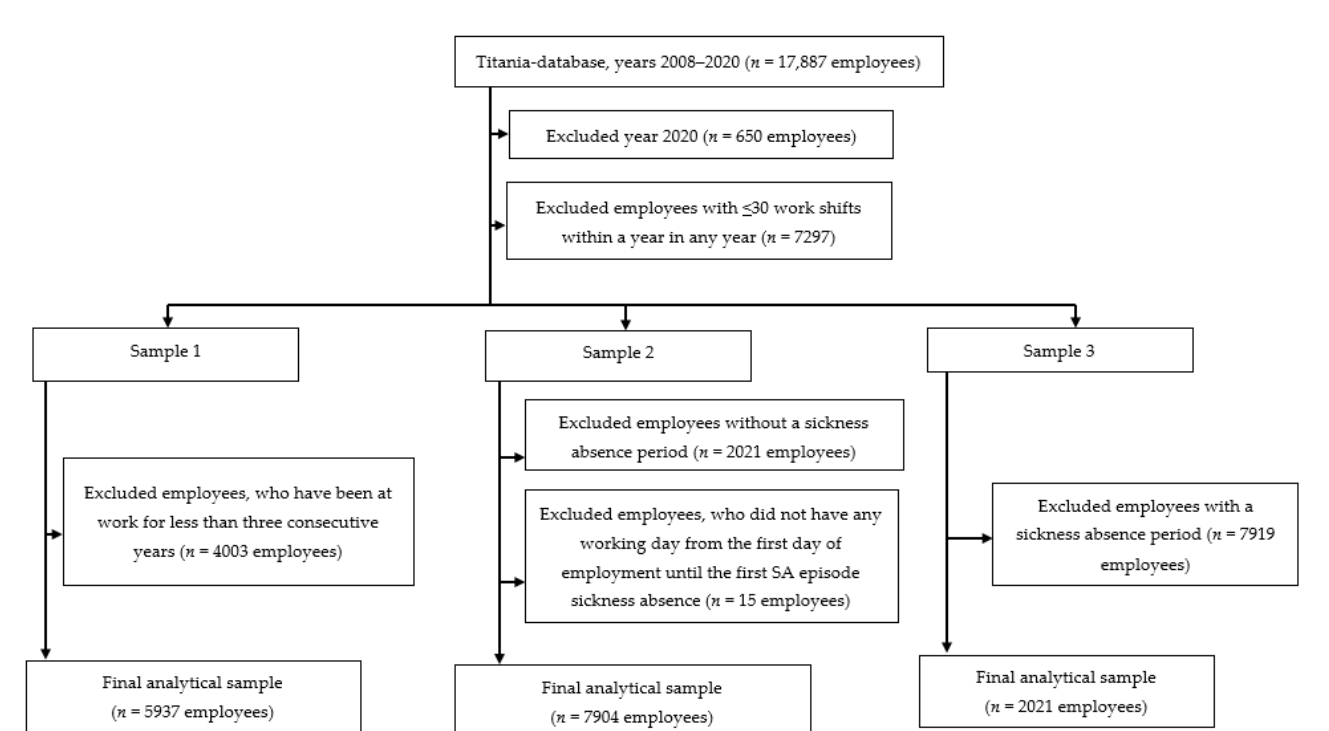
Figure 1. The flowchart of data selection for samples 1, 2, and 3.